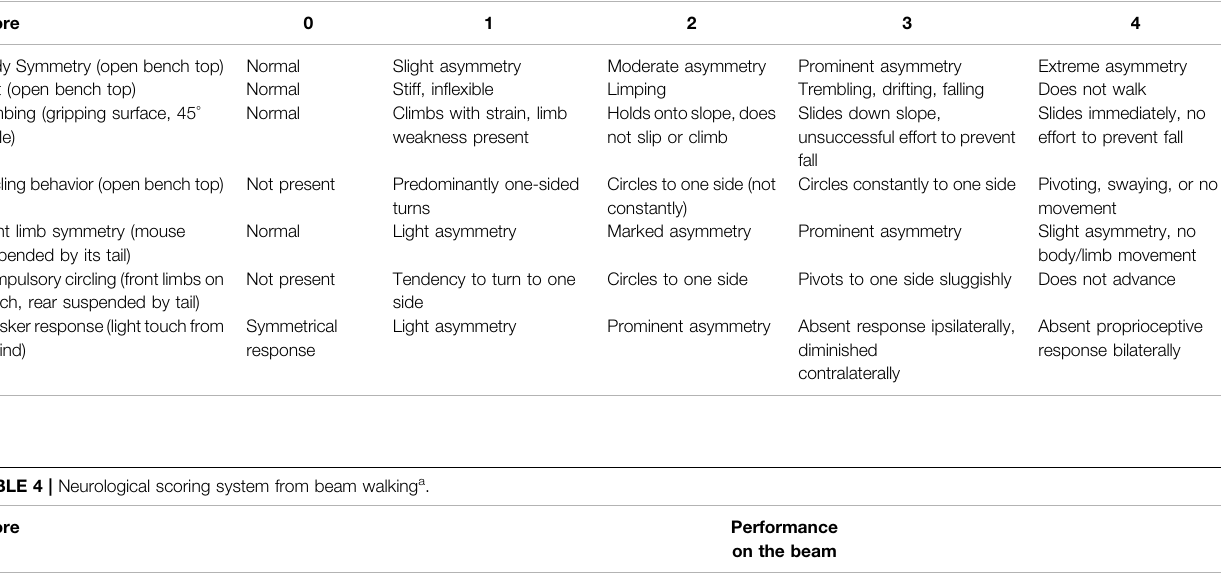
Traversesbeamnormallywithbothaffectedpawsonhorizontalbeamsurface,neitherpawevergraspsthesidesurface,and there are no more than two footslips; toe placement style is the same as preinjury